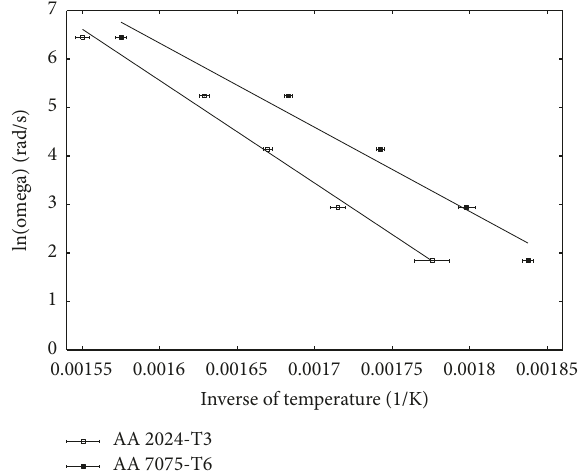
Figure 10: Arrhenius plots showing the logarithm of the frequency versus the reciprocal of the temperature for the tails of the peaks observed for AA 7075-T6 and 2024-T3 at high